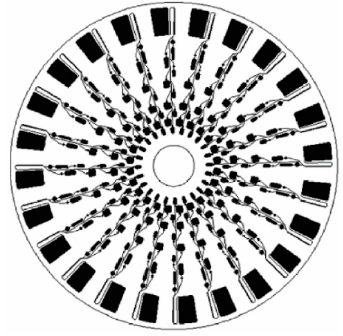
Figure 9. Schematic of CD-ELISA design with 24 sets of assays. Reprinted with permission from the American Chemical Society [77].